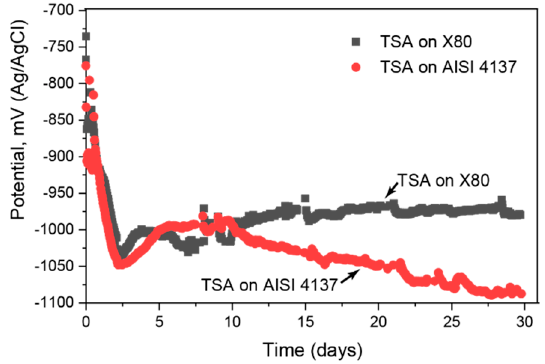
Figure 3. OCP of TSA-coated steels over the test duration.